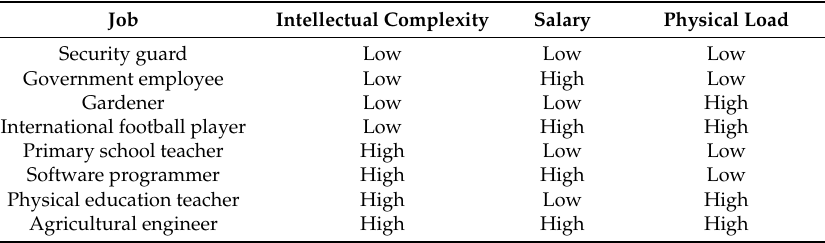
Table 1. Jobs selected for the job-sorting